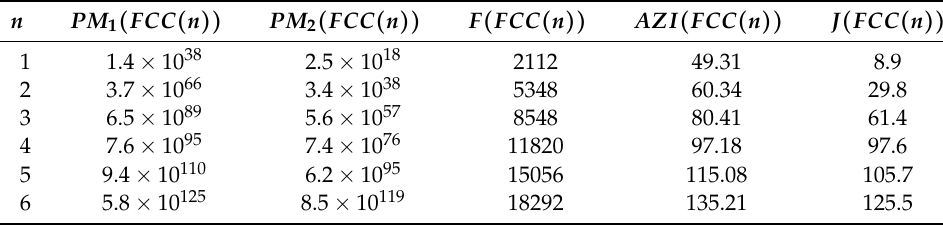
Figure 10. The graphical representation of ABC 4 index and GA 5 index of face-centered cubic lattice FCC ( n ) . The colors brown and green represent ABC 4 and GA 5 , respectively. Table 3. Comparison of all indices for face-centered cubic lattice FCC ( n )